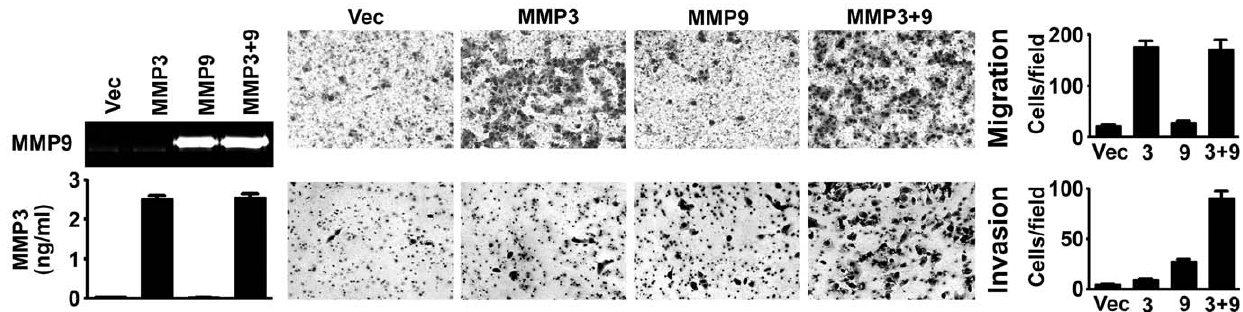
Figure 7. MMP3 enhances cell migration and synergizes with MMP9 to promote cell invasion. HONE-1 cells were transfected with a vector plasmid (Vec), a MMP3-expressing plasmid, or a MMP9-expressing plasmid, or cotransfected with both MMP3 and MMP9 plasmids (MMP3 + 9). production of MMP9 was examined by using a gelatin zymography assay, and production of MMP3 was examined by using ELISA. A transwell migration assay and a Matrigel invasion assay were performed. Shown are the microscopic observations of migrating or invading cells and the average numbers of the cells per field.